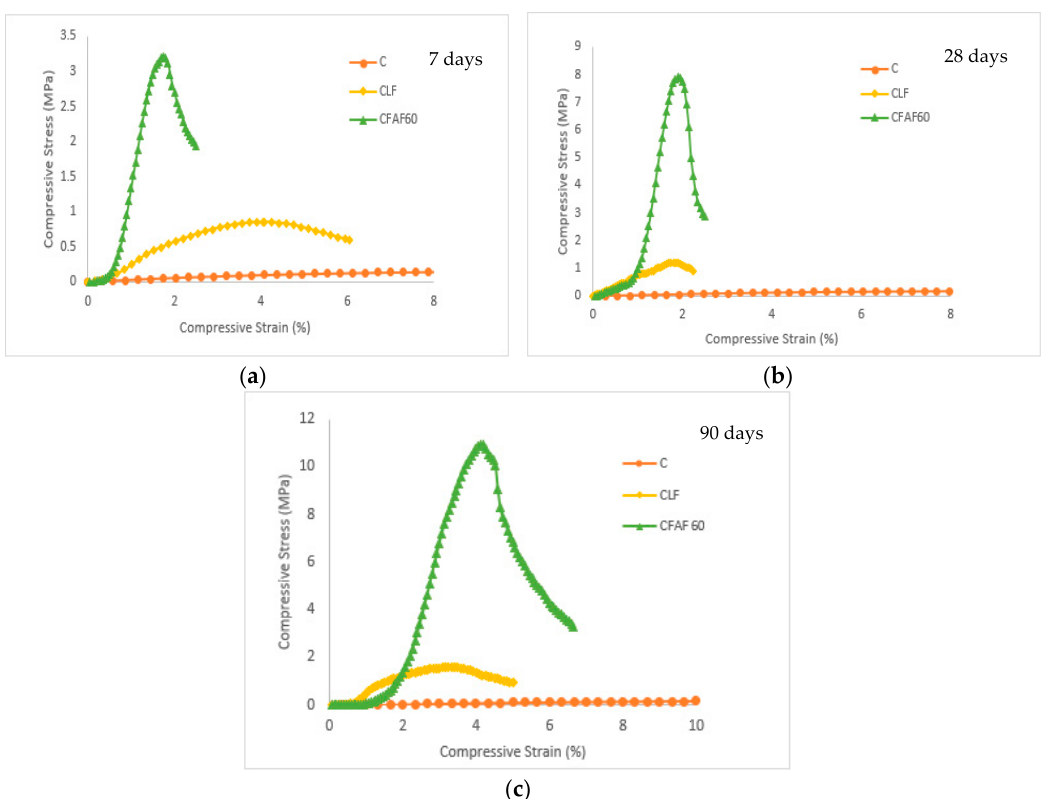
Figure 3. Compressive stress vs. compressive strain for ( a ) 7 days, ( b ) 28 days and ( c ) 90 days.